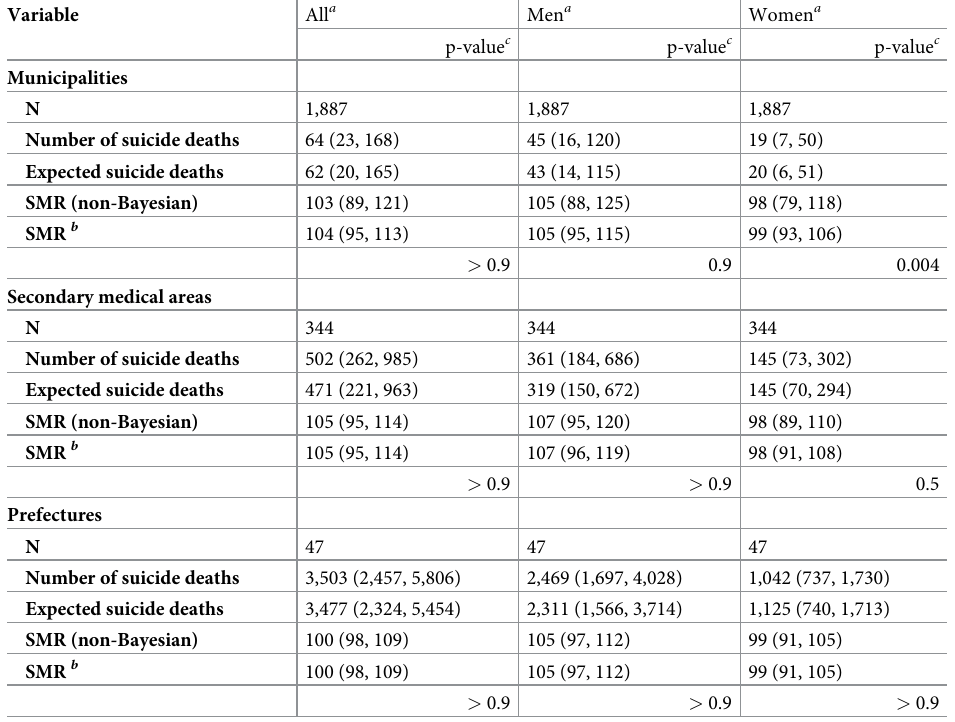
Table 1. Number of suicides, expected suicide deaths, and standardized death ratios.